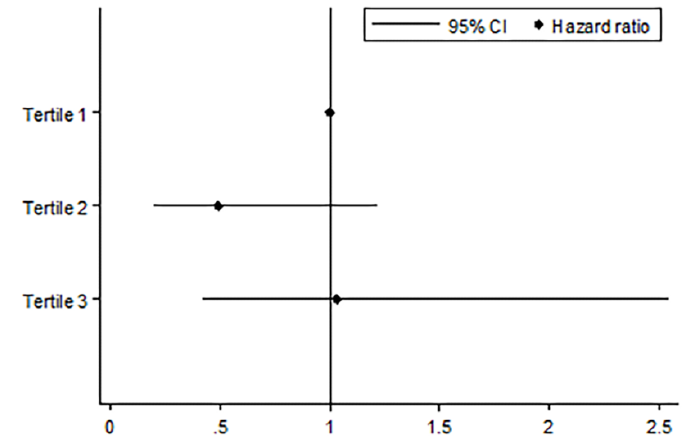
Figure 5. Comparison of mortality risk by annual rates of decline in Kco. Footnotes: All